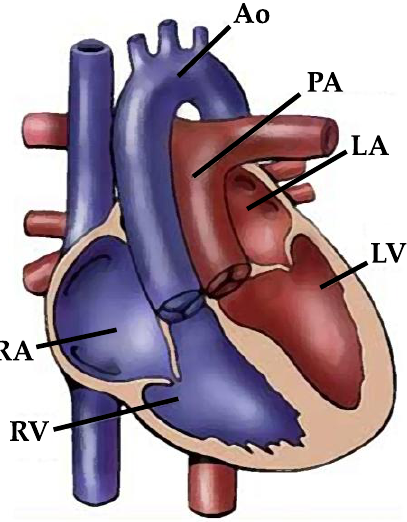
Figure 2. Diagram of TGA with ventriculo-arterial discordance and without spiralization of the great arteries. RA: right atrium; RV: right ventricle; LA: left atrium; LV: left ventricle; Ao: aorta; PA: pulmonary artery.